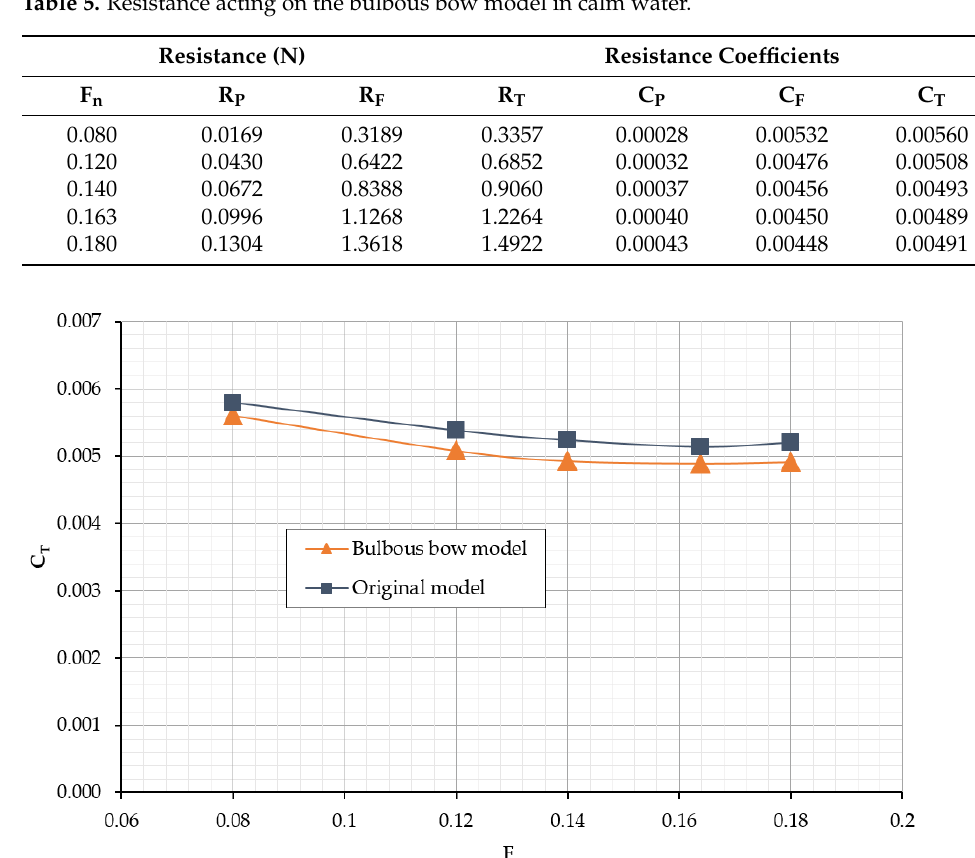
Figure 11. Comparison of the total resistance coefficients of the ships.